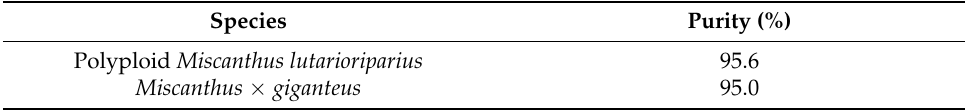
Table 2. The purity of CNCs extracted bisulfuric acid hydrolysis.